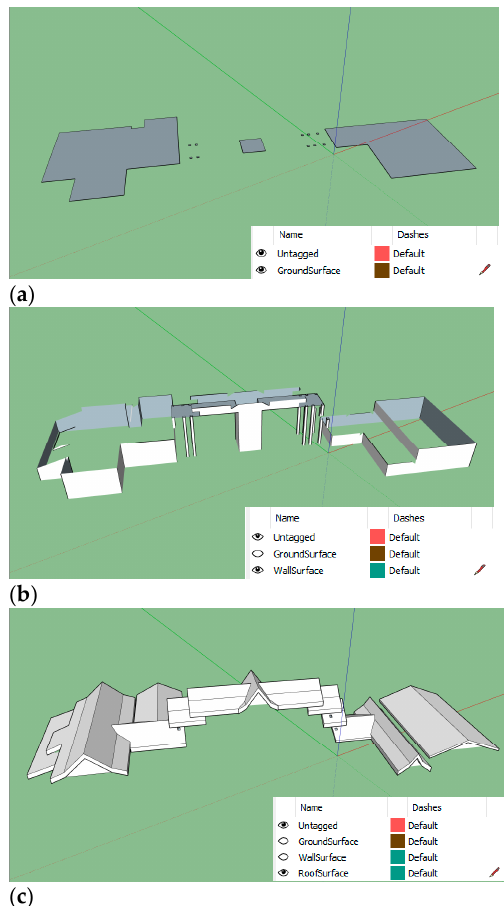
Figure 5. 3D model drawn in SketchUp according to ( a ) “GroundSurface” layer, ( b ) “WallSurface” layer and ( c ) “RoofSurface” layer.